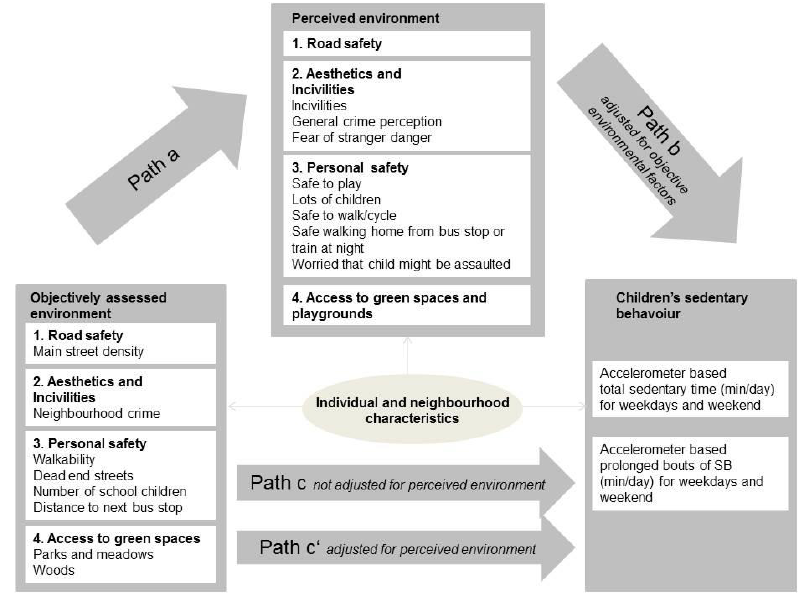
Figure 1. Mediation effects of the perceived environment on the associations between